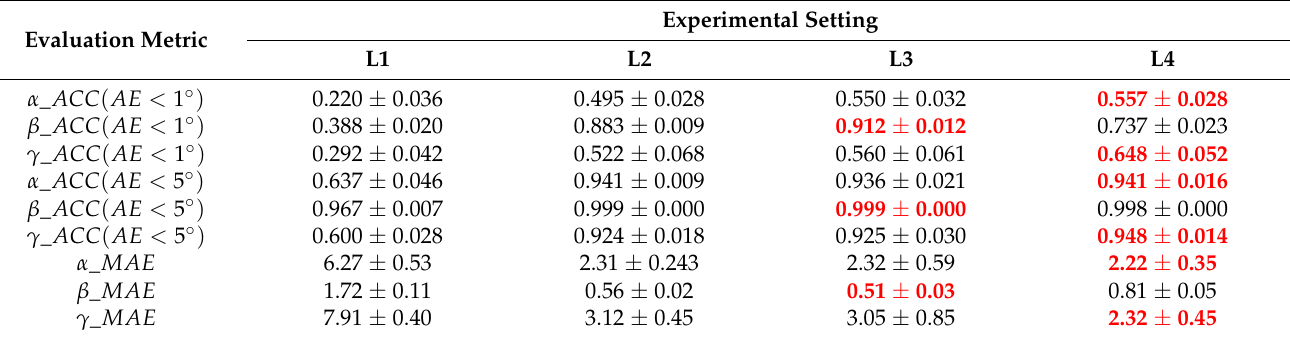
Table 3. Performance of different loss function settings. The optimal results are tabulated in